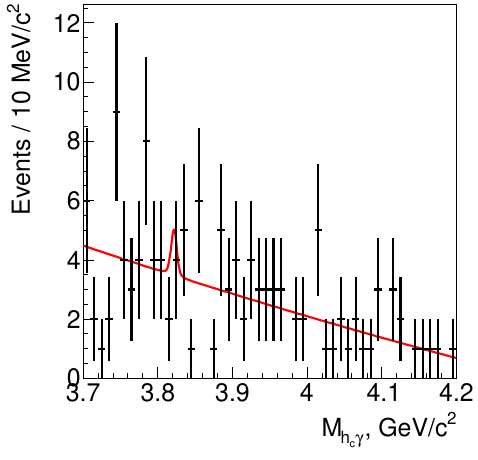
(right). (cid:17) c 2 (1 D ) K 0 S !